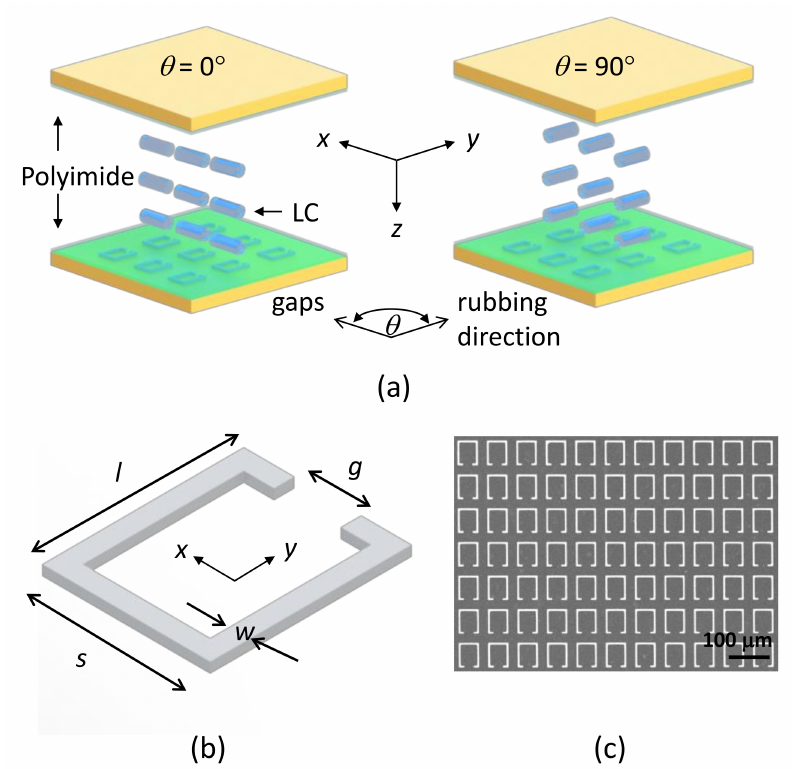
Figure 1. ( a ) Schematic configuration of twelve metamaterial-imbedded liquid crystal (LC) cells at θ = 0 ◦ and 90 ◦ . θ is an angle between the rubbing direction of the polyimide layers and the gaps of the split ring resonators (SRRs) of the metamaterial in a metamaterial-imbedded LC cell. ( b ) Dimensions of SRR. ( c ) Scanning electron microscope image of